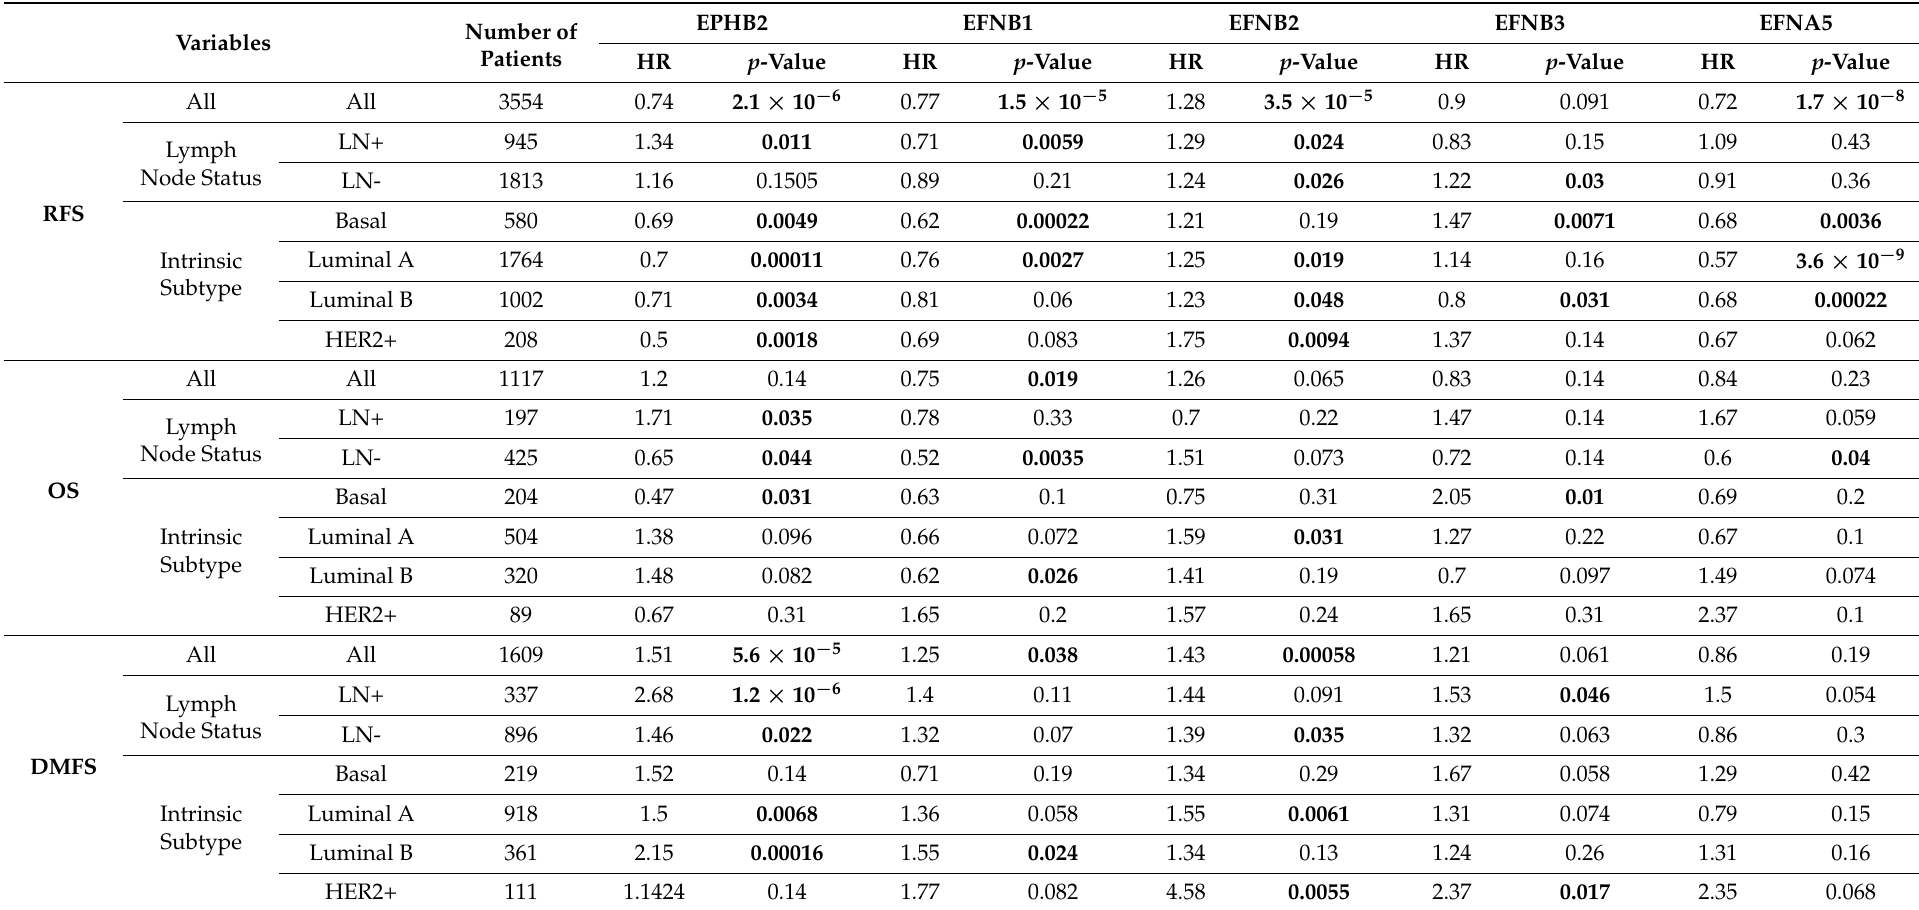
Table 1. Survival outcomes derived from Kaplan–Meier analysis according to different clinico-pathological variables, EphB2 gene expression and different cognate ligand-encoding EFN genes. Abbreviations: RFS: relapse-free survival; OS: overall survival; DMFS: distant metastasis-free survival; HR: hazard ratio (confidence interval (CI) = 95%). The indicated p -values were calculated by the log-rank test. In bold, p -values of <0.05 are considered as statistically